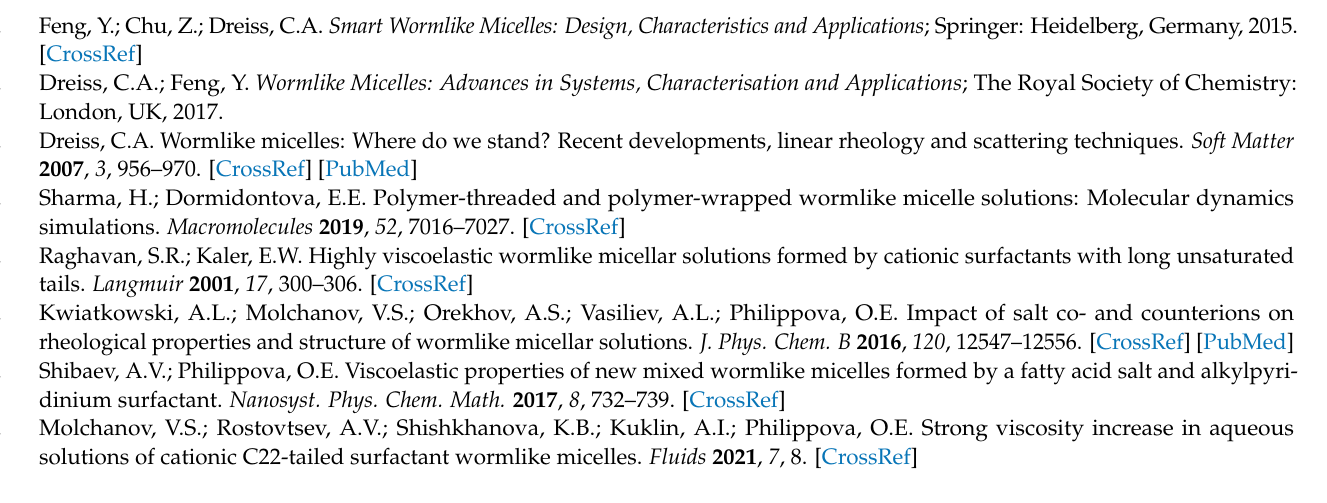
Figure S2: Frequency dependences of the storage modulus G’ (filled symbols) and loss modulus G” (open symbols) for aqueous solutions containing 78 mM potassium oleate, 39 mM (a) or 117 mM (b) C8TAB and different concentrations of 1-phenylhexane indicated in the Figure: 0 mM (squares), 12 mM (circles), 18 mM (tiangles), 25 mM (diamonds). Temperature: 200C, pH 11. Figure S3: Dependences of zero-shear viscosity on the molar ratio β · [additive]/[surfactant] (a) or on the volume ratio p · (vol. additive)/(vol. surfactant) (b) for aqueous solutions containing 78 mM potas-sium oleate, 39 mM (filled symbols) or 117 mM (open symbols) C8TAB and different additives: AA (squares), NIPA (triangles), 1-phenylhexane (diamonds), n-decane (circles). β are arbitrary shift factors, and p are partitining coefficients determined form DOSY data (Table 2). Figure S4: Dependences of relative viscosity on monomer concentration for solutions of AA in H 2 O (circles), AA in D 2 O (triangles), NIPA in H 2 O (diamonds), NIPA in D 2 O (squares). Temperature 20 0 C. Figure S5: Pseudo-2D DOSY spectrum for 39 mM C8TAB solution in D2O, pH